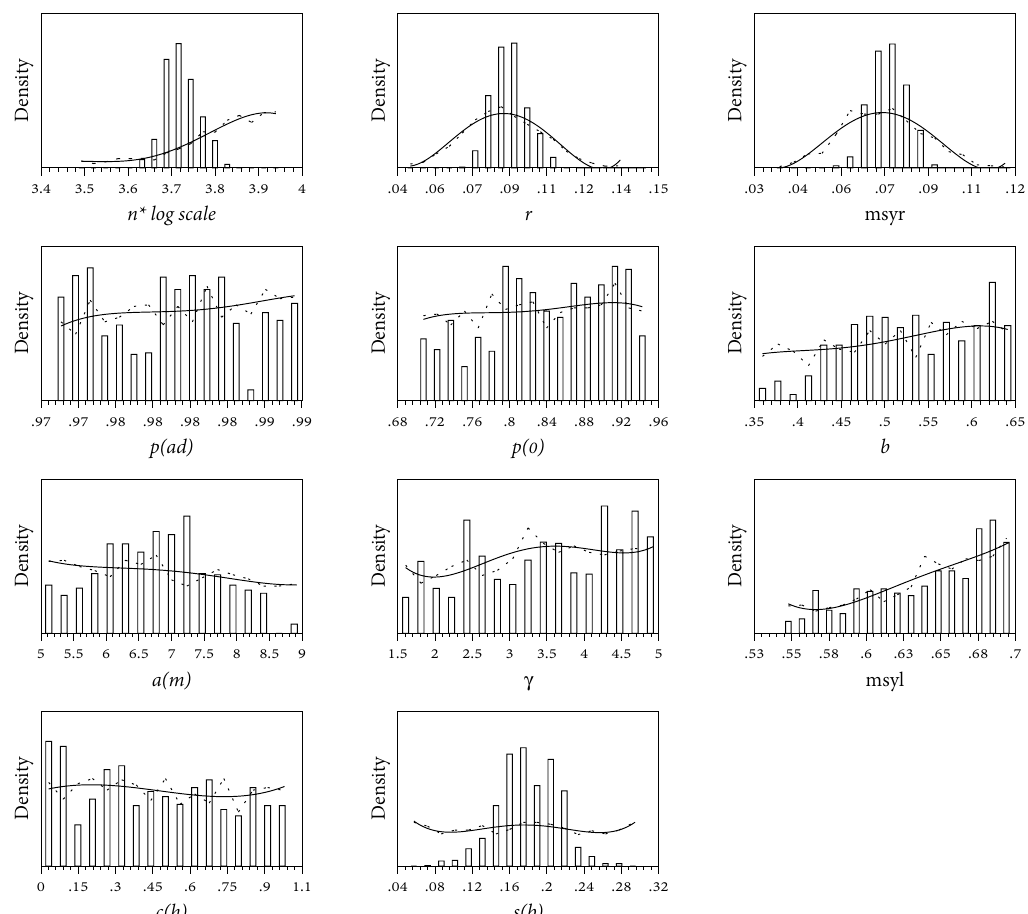
Fig. 5. Realised prior (dashed curve; solid curve fitted polynomial) and posterior (bars) parameter distributions for density-regulated growth in Baffin Bay walruses (model dB). For parameter symbols see Table